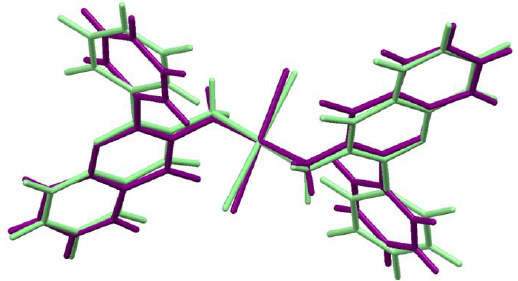
Figure 3. Overlaid geometries of trans -Pt(3-af) 2 Cl 2 molecules: present in the crystal structure (purple) and optimized at the B3LYP/def2-TZVPP level (light green).